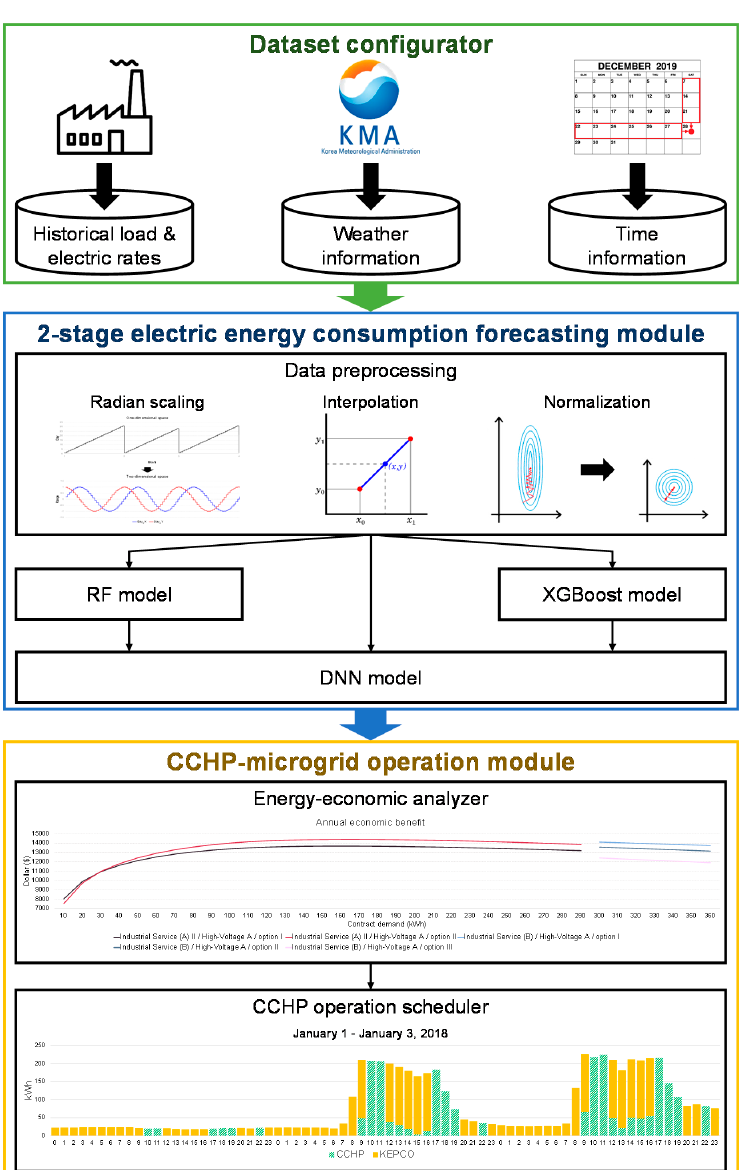
Figure 1. Overall system architecture.